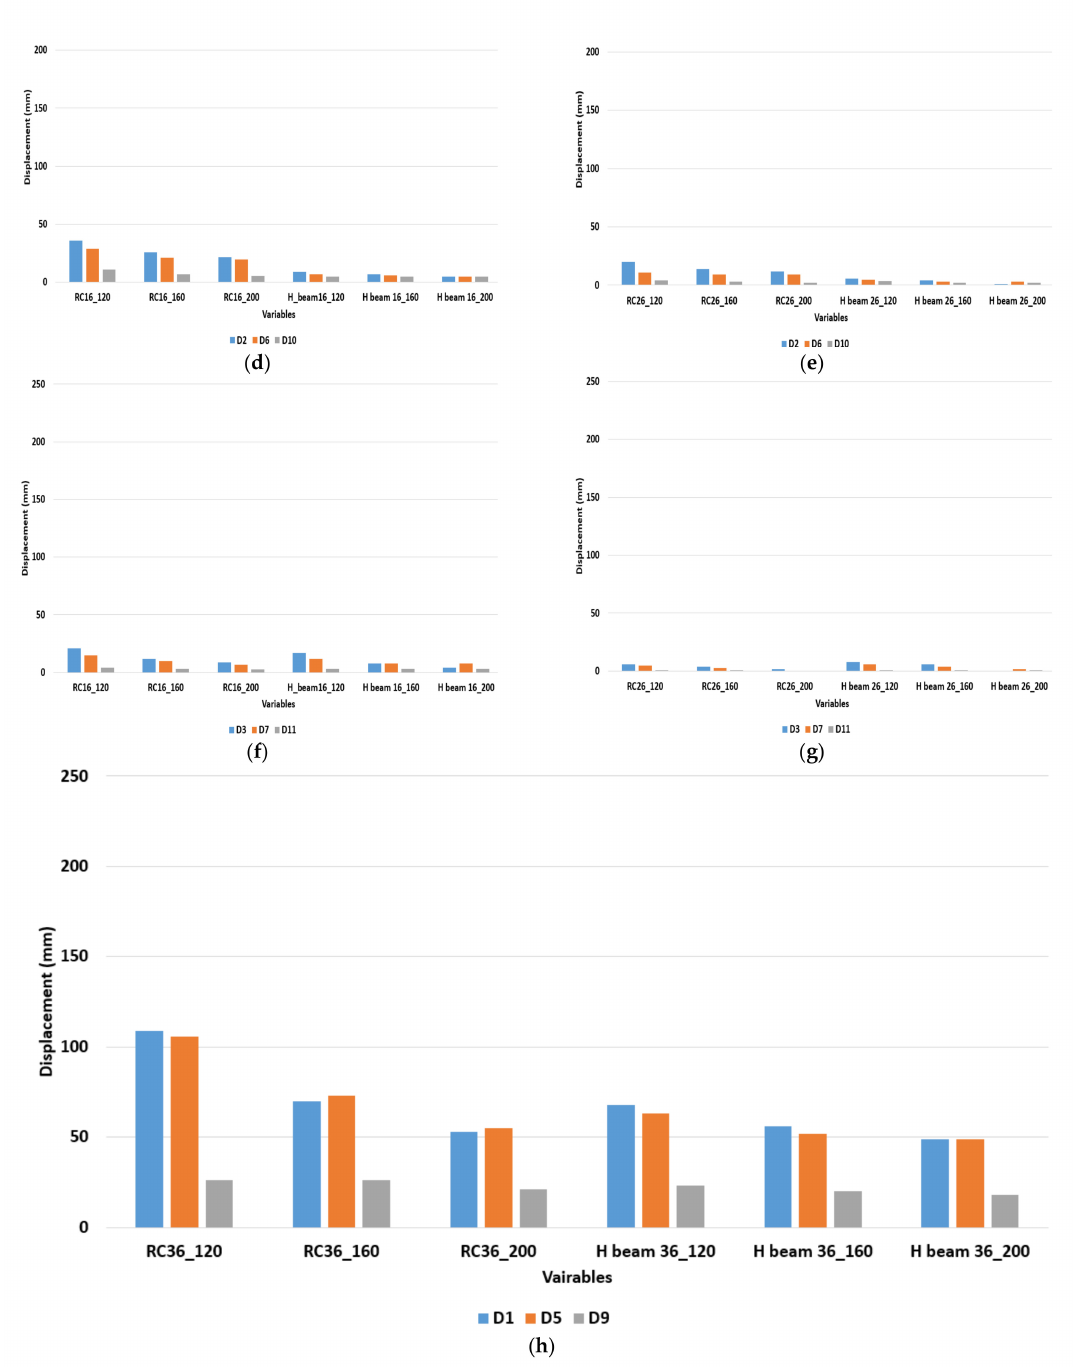
Figure 9. ( a ) Position of displacement probe; ( b ) Reinforced and composite protection structure displacement at a distance of 1.6 m from different elements; ( c ) Reinforced and composite protection structure displacement at a distance of 2.6 m from different elements; ( d ) Reinforced and composite protection structure displacement at a distance of 1.6 m from different elements; ( e ) Reinforced and composite protection structure displacement at a distance of 2.6 m from different elements; ( f ) Reinforced and composite protection structure displacement at a distance of 1.6 m from different elements; ( g ) Reinforced and composite protection structure displacement at a distance of 2.6 m from different elements; ( h ) Reinforced and composite protection structure displacement at a distance of 3.6 m from different